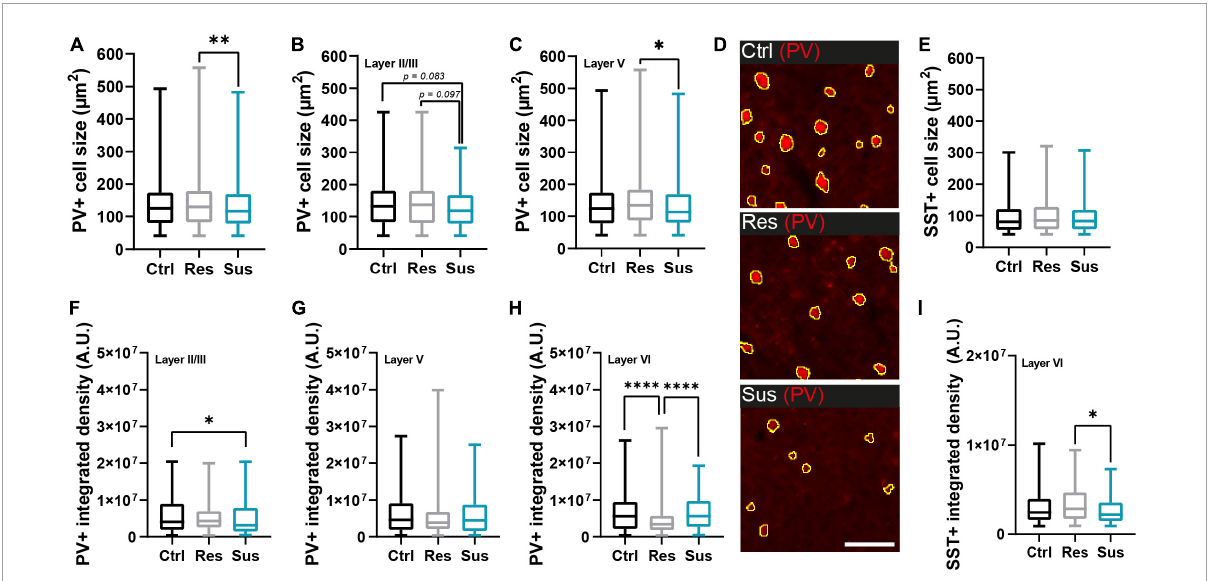
FIGURE3 Interneuron populations are morphologically changed in the primary motor cortex (M1) long-term after CSDS depending on stress vulnerability. (A) Cell size changes of parvalbumin positive (PV+) cells in M1 and (B,C) its layers II/III and V (unchanged layer VI in Supplementary Figure 3 ). (D) Examples of PV+ cells from layer V in the different behavioral groups (scale bar = 100 µ m). (E) Cell size of somatostatin positive (SST+) cells in M1. (F–H) Integrated density expressed as alterations of PV+ cells in the different M1 layers. (I) Intensity alterations of SST+ cells in layer VI (unchanged layers II/III and V in Supplementary Figure 3 ). ∗ P < 0.05, ∗∗ P < 0.01, ∗∗∗∗ P < 0.0001. Results are shown as median, 25th and 75th percentiles, and